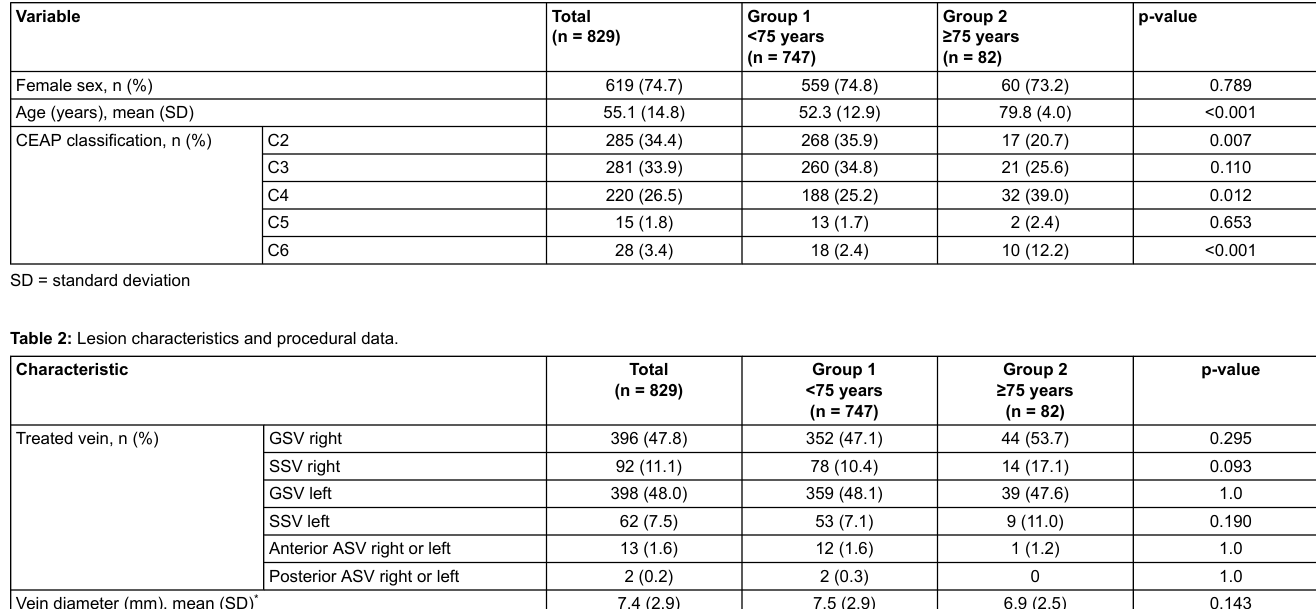
Table 1: Patient demographics.